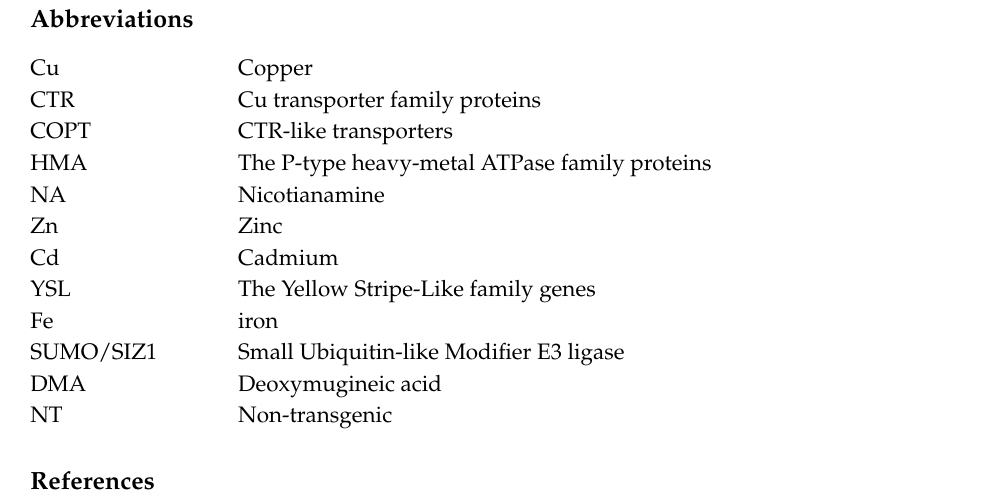
Figure S2: Generation of AhYSL3.1 -induced transgenic plants, Figure S3: Fe concentrations in the NT and transgenic lines treated with various concentrations of Cu, Figure S4: Mn concentrations in the NT and transgenic lines treated with various concentrations of Cu, Figure S5: Zn concentrations in the NT and transgenic lines treated with various concentrations of Cu, Figure S6: Relative expression level of AhYSL3.1 in young leaves of NT and transgenic rice plants under excess Cu conditions, Figure S7: Metal concentrations in young leaves and roots of transgenic and NT tobacco plants under Fe-deficient conditions, Figure S8: A model illustrates the transport of Cu by AhYSL3.1 in transgenic tobacco treated with excess